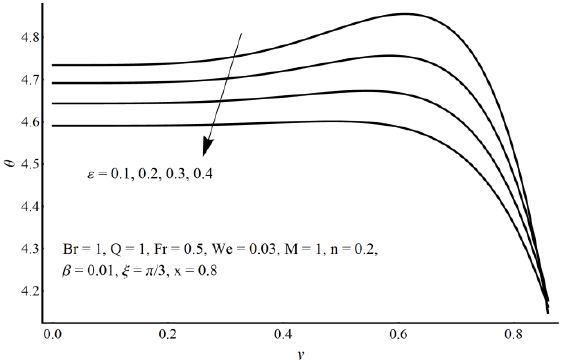
Figure 9. Temperature profile for different values of ε.